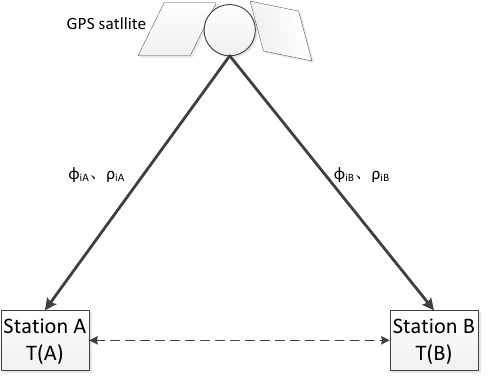
Figure 1. The sketch of Global Positioning System (GPS) Common View (CV).